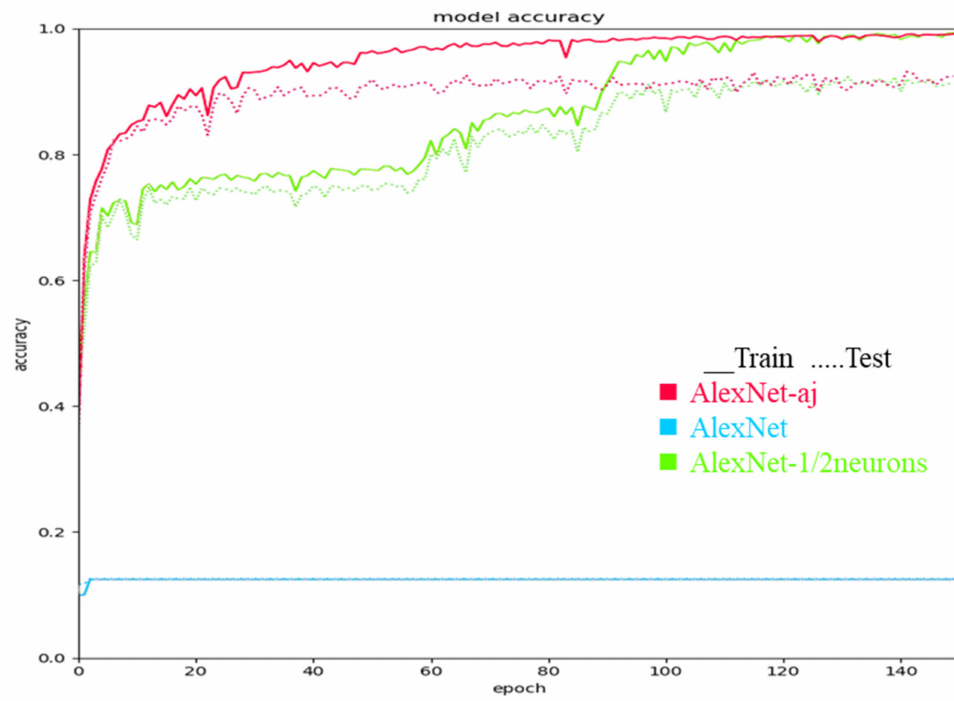
Figure 2. Test results of neuron number adjustment.